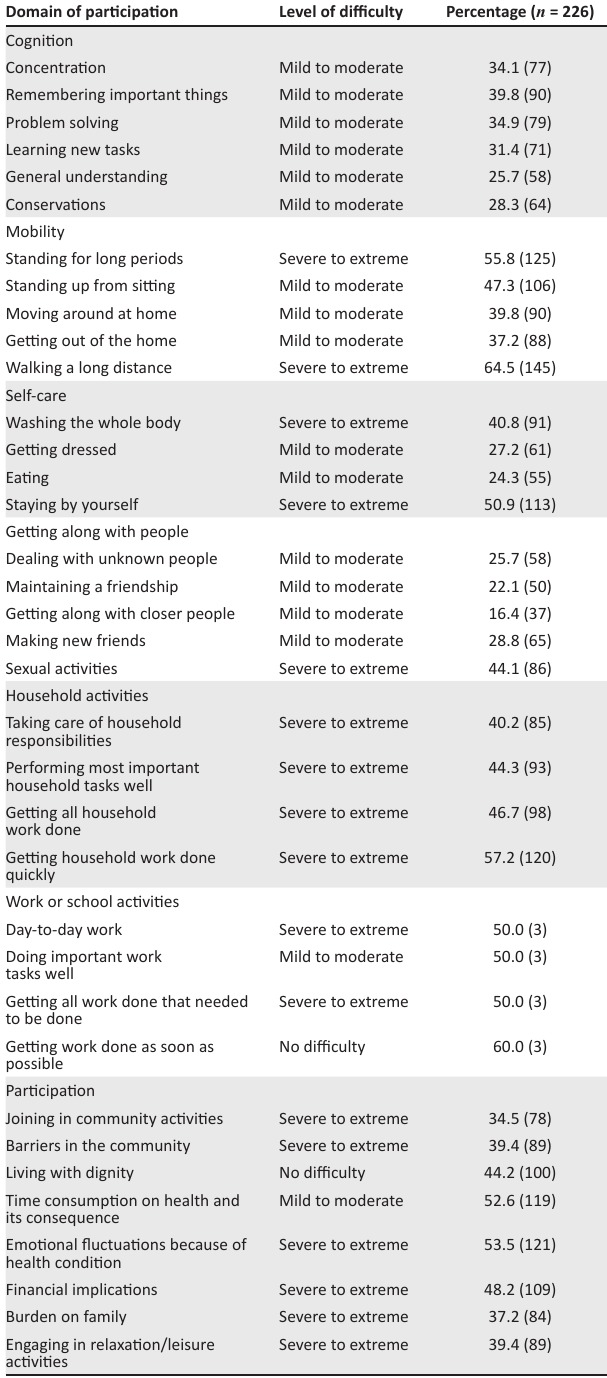
TABLE 1: The extent of functional limitation for the patients. Domain of